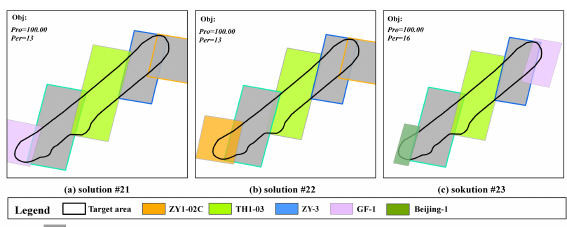
Figure 5. The scheduling schemes for Scenario B